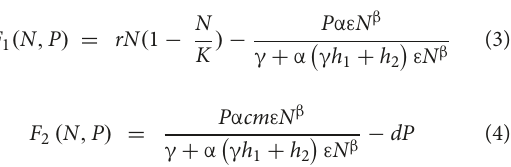
ε ,herddensity(km − 2 )atapreydensityof1individual/km 2 ; β ,slopeoflog(herddensity)vs.log(preydensity)linearrelationship; r ,maximumpercapitarateofgrowthforprey(day − 1 ); mean( N ),meanpreypopulationdensity(km − 2 )recordedover80censusesduring2005–2012; m ,massofmeat(kg)oneachadultcarcass; w ,adultfemalebodyweight(kg); s ,probability (valued between 0 and 1) that a lion will choose to attack an encountered prey group; p , probability of successful prey capture; h 1 , the time spent capturing each prey item (day); h 2 , the